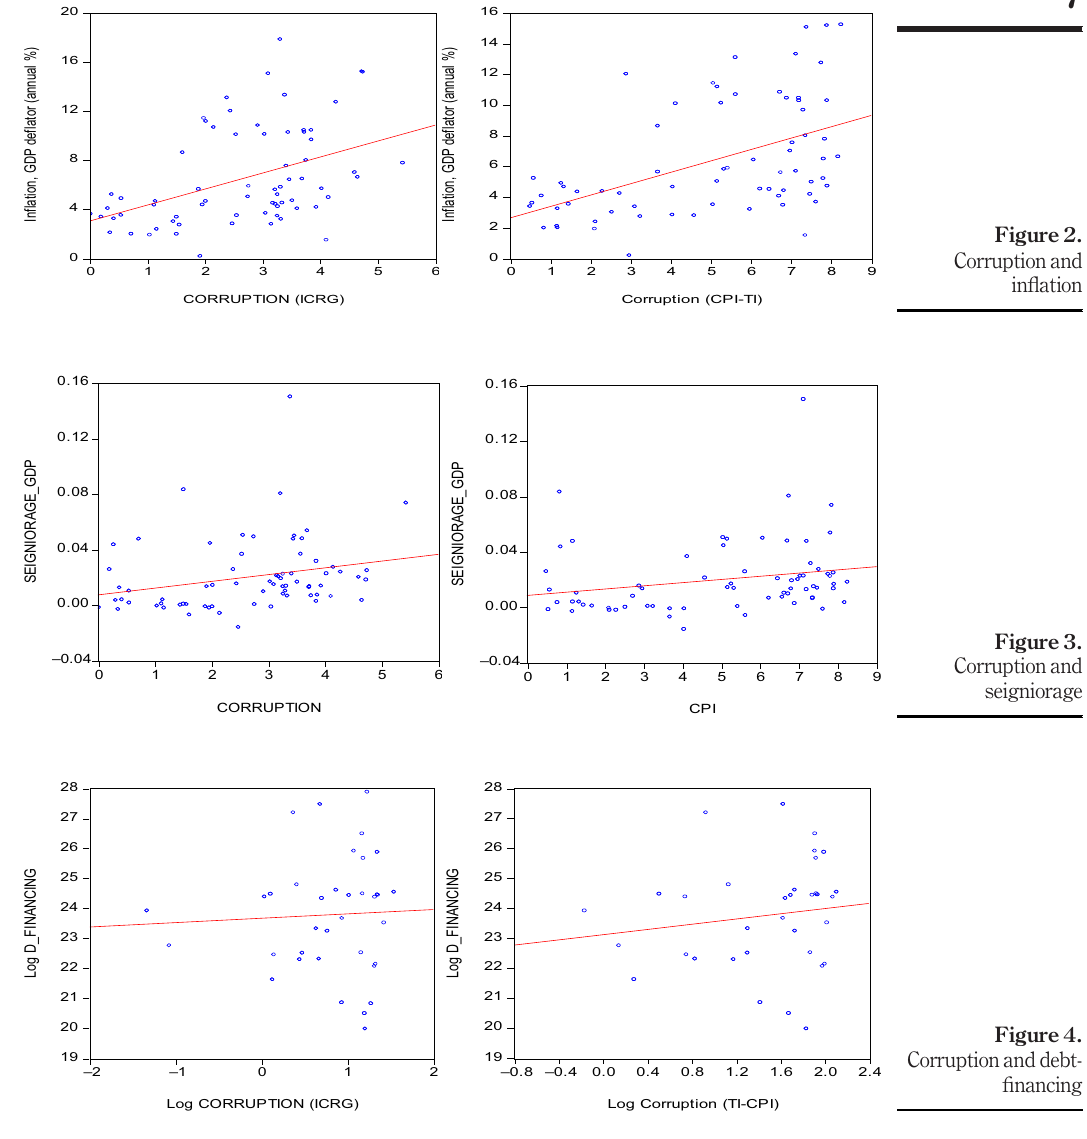
Figure 2. Corruption and in fl ation